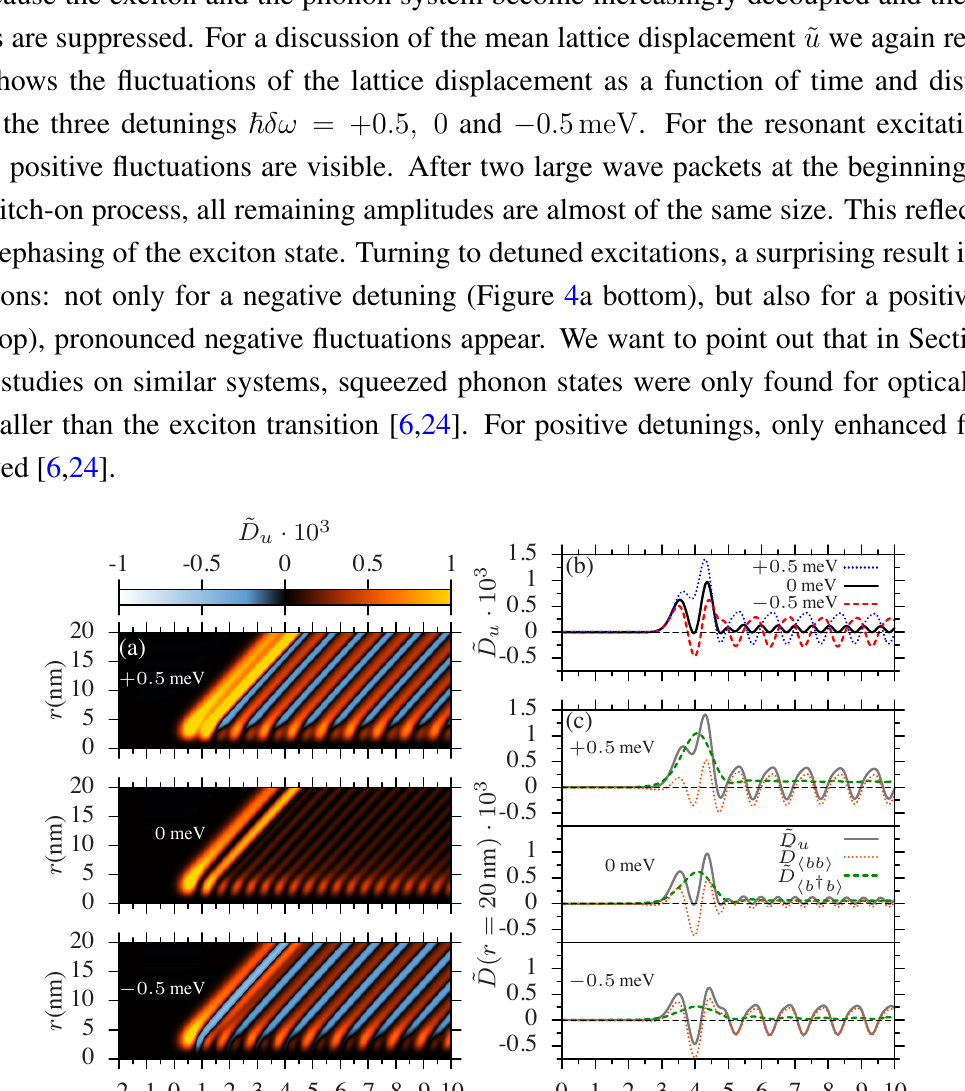
Figure 4. ( a ) Fluctuations of the lattice displacement ˜ D 1 ; ( b ) temporal shape of the fluctuations of the lattice = 6 ps for a Rabi frequency Ω − R displacement ˜ D from (a) at r = 20 nm ; ( c ) same as Figure 3 but for Ω u